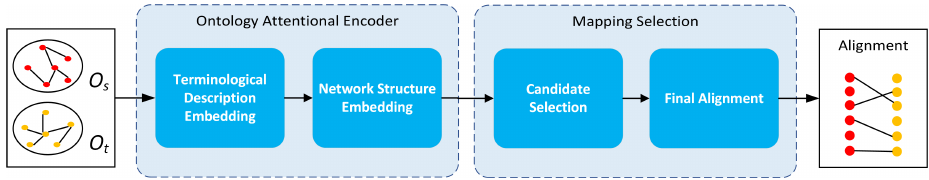
Figure 1. The conceptual framework of Deep Attentional Embedded Ontology Matching